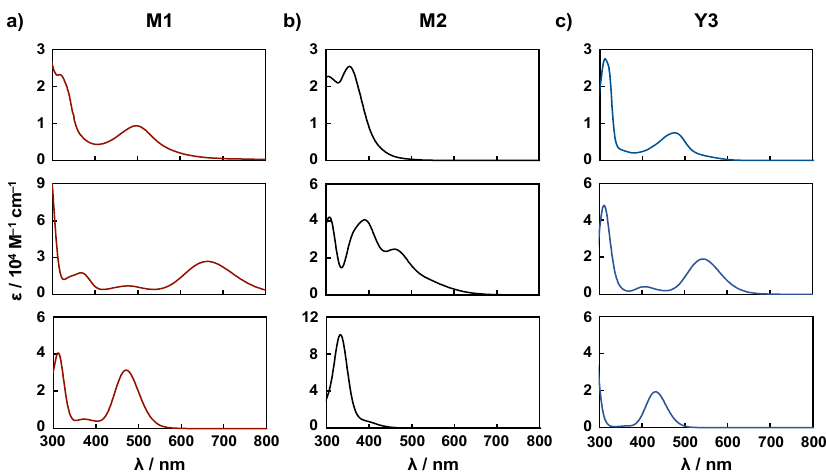
Figure 3. UV-vis absorption spectra of ( a ) M1 , ( b ) M2 , and ( c ) Y3 measured in EtOH (top), as calculated using B3LYP (middle) and CAM-B3LYP (bottom). Table 3. UV-vis absorption spectroscopic data for M1 , M2 , and Y3 estimated by DFT calculations.